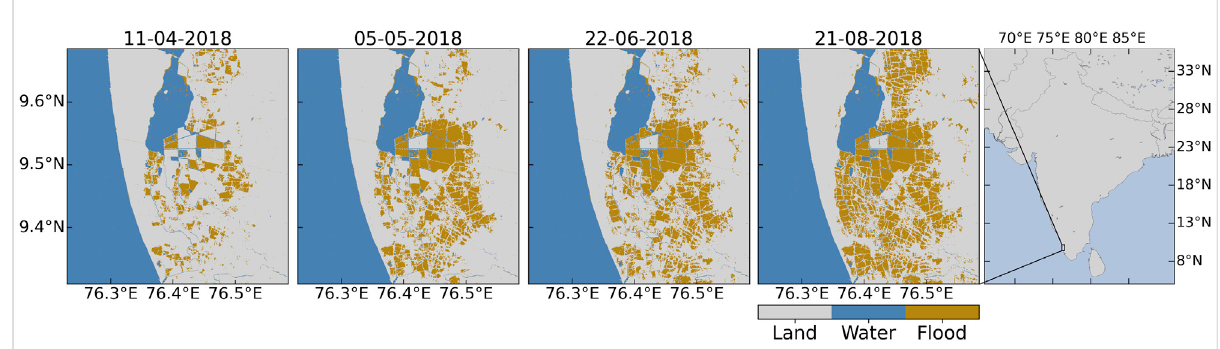
FIGURE 8 ThesurfaceimagesofVembanadlake,Kerala,India,beforeandaftertheincidenceof fl oodswereretrievedfromSentinel-1Aand-1Bsynthetic- aperture radar (SAR) images, available from the Copernicus Open Access Hub (https://scihub.copernicus.eu; 2018 – 2020, data accessed on 22 April 2021).Level-1GroundRangeDetected(GRD)SARproductswereprocessedat10 mspatialresolutionusingtheSentinelApplicationPlatform(SNAP) fromtheEuropean Space Agency (ESA). Blue indicates water bodies(ocean/lake), brown areasindicate fl ooding.The information on theextent of the fl ooding could be used in combination with socio-economic data to derive estimates of economic loss across the fl ooded